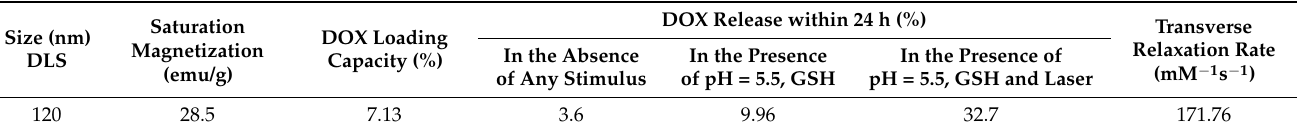
Table 10. The main characteristics of an Fe 3 O 4 /polydopamine/hyaluronic acid